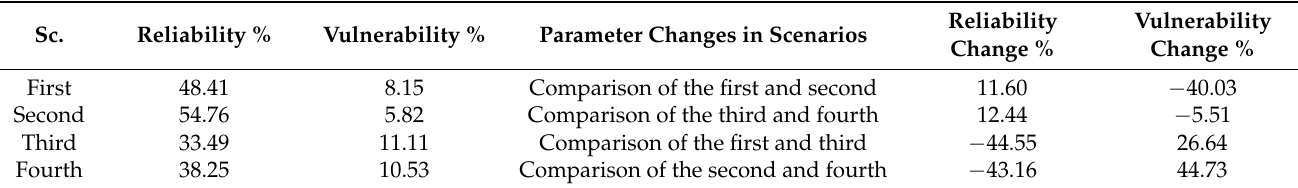
Table 4. Vulnerability and Reliability Indexes in the four scenarios (HR).